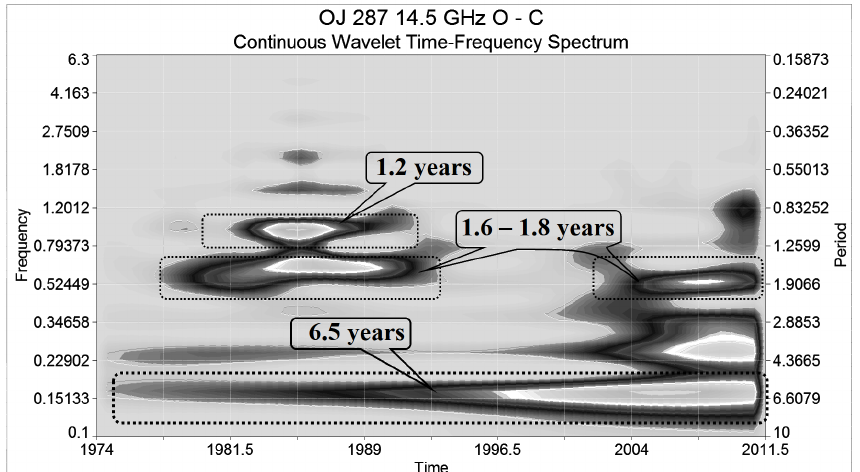
Fig. 2. The wavelet spectrum for OJ 287 at 14.5 GHz. The text boxes indicate the periods in